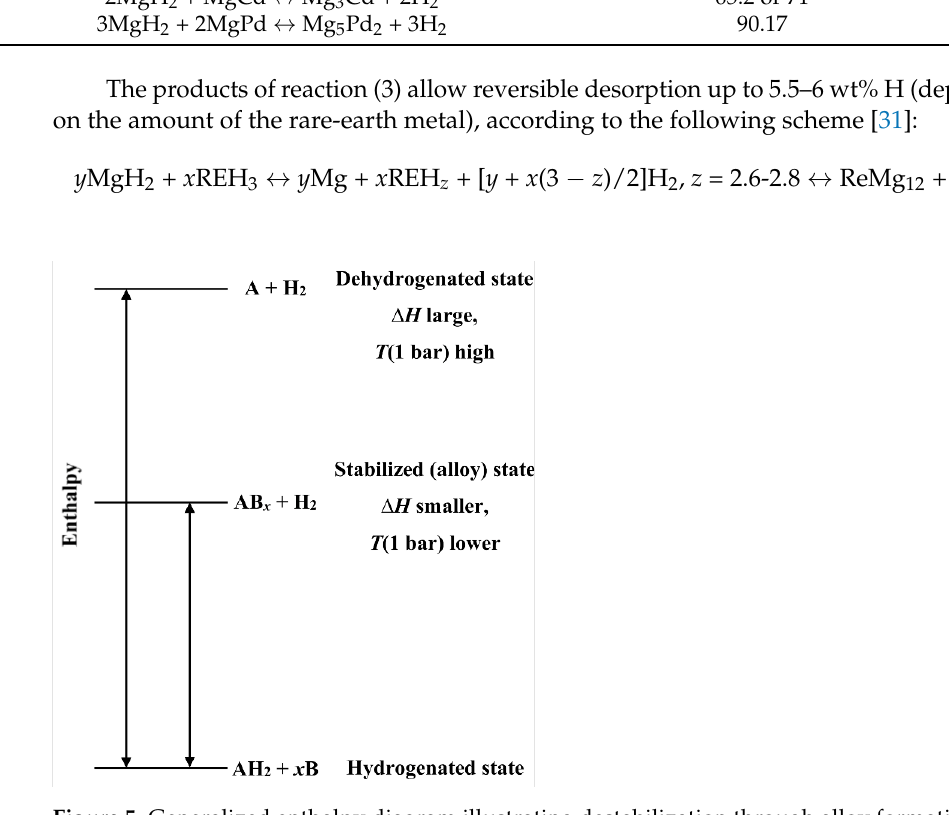
Figure 5. Generalized enthalpy diagram illustrating destabilization through alloy formation upon dehydrogenation. Reproduced with permission [133]. Copyright 2007,